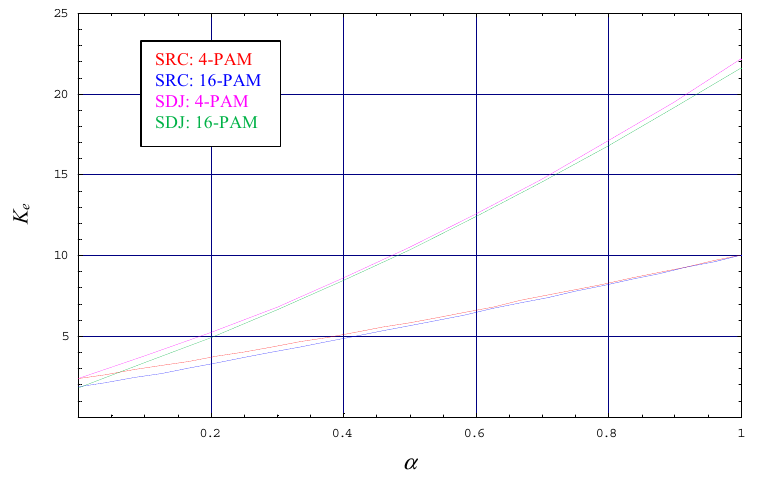
Figure 5. Detector slope for dual-filter solutions.